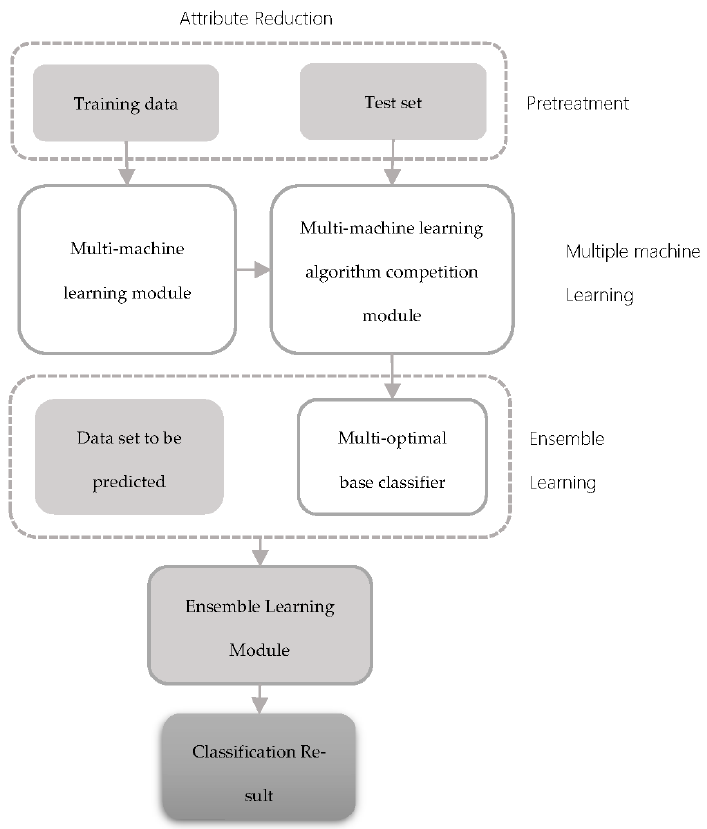
Figure 3. Algorithmic framework of multi-machine learning competitive strategy.